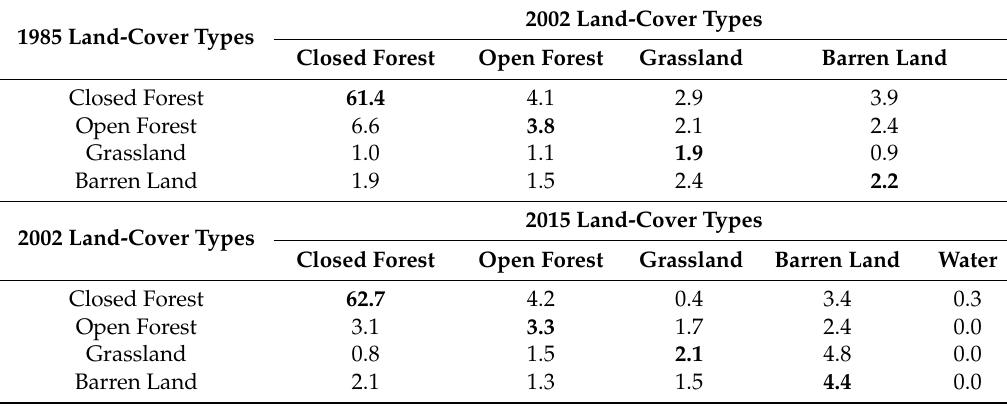
Table 5. Land-cover change matrix as percentage of the study area (21,232.8 ha).